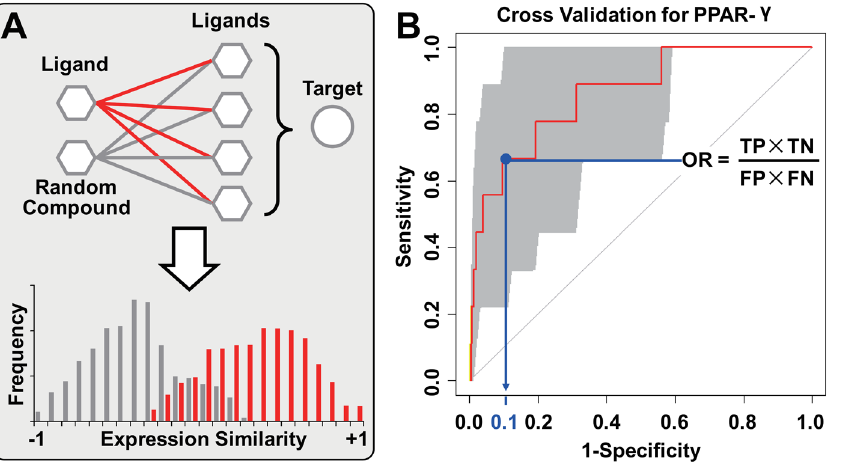
Figure 4. The rationale and performance of DTI prediction model. (A) If a target has its ligand-binding well characterized by CMap, we expect the potential ligands to show higher BAES to benchmark ligands (red colored connections) than random compounds do (grey colored connections), i.e. the LOI of ligands should excel the overall background of CMap. (B) For the cross validation of PPAR- c , the area under ROC curve reaches 0.86, with the 95% confidence interval (i.e. the grey colored shape) ranging from 0.74 to 0.99. The LOI corresponding to 90 percent specificity is set as the threshold to discriminate positive and negative sets. Thus, only 10 percent of the negative set is above the threshold, i.e. there would be 130 false positive (FP) and 1170 true negative (TN) compounds. Meanwhile, 67 percent of the positive set is above the threshold, so there would be 6 true positive (TP) and 3 false negative (FN) compounds. The statistical significance of such enrichment (odds ratio=18) is determined by Fisher’s exact test (p=7.31 6 10 2 5